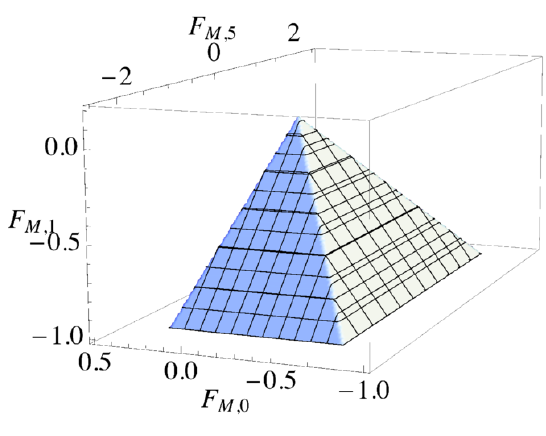
Figure 7 . In a subspace spanned by three coe(cid:14)cients, F M; 0 , F M; 1 and F M; 5 , allowed parameter space is described by a